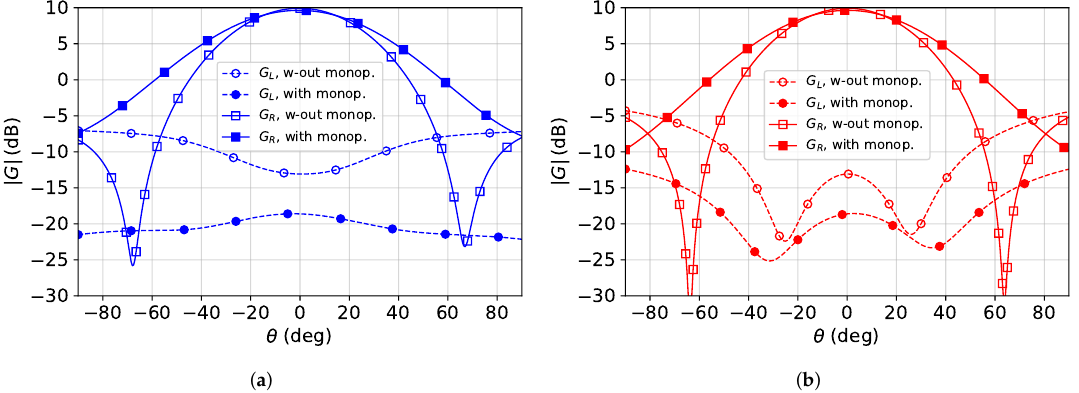
Figure 5. Simulated RHCP ( G R ) and LHCP ( G L ) gain patterns versus elevation angle with (filled markers) and without (empty markers) monopoles around the 2-by-2 array, for the cut-planes at ( a ) φ = 0 ◦ and at ( b ) φ = 90 ◦ . The results are provided at the central frequency f = 2.2